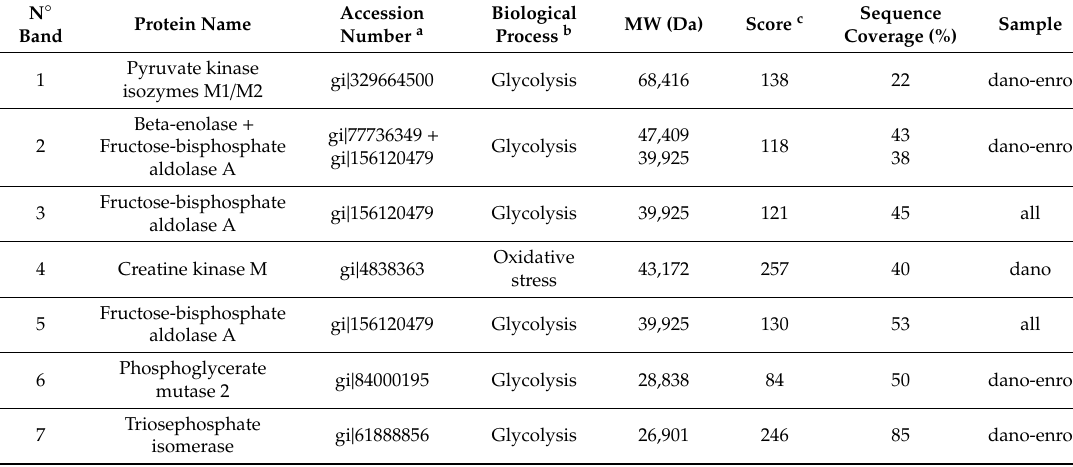
Table 2. Identification of oxidized sarcoplasmic proteins according bands selected by Western blot from blank and treated samples with danofloxacin or enrofloxacin.